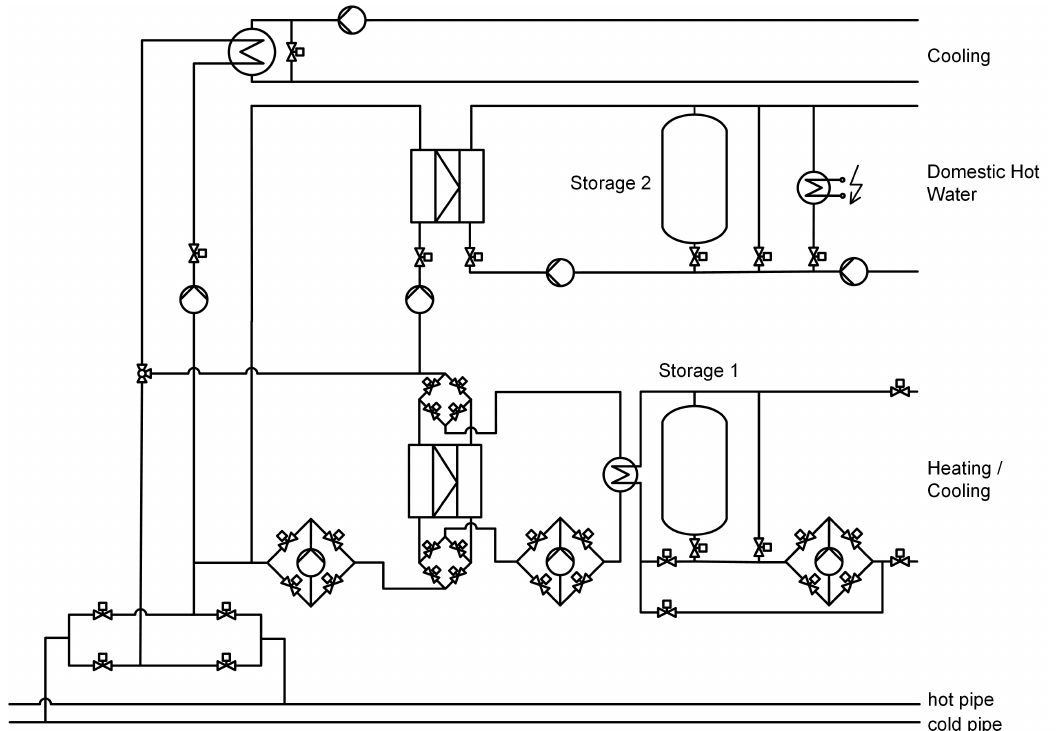
Figure 6. Schematic hydraulic diagram of a fully equipped ETS and its main components: heat pumps, heat exchangers, circulation pumps, short term water storages and